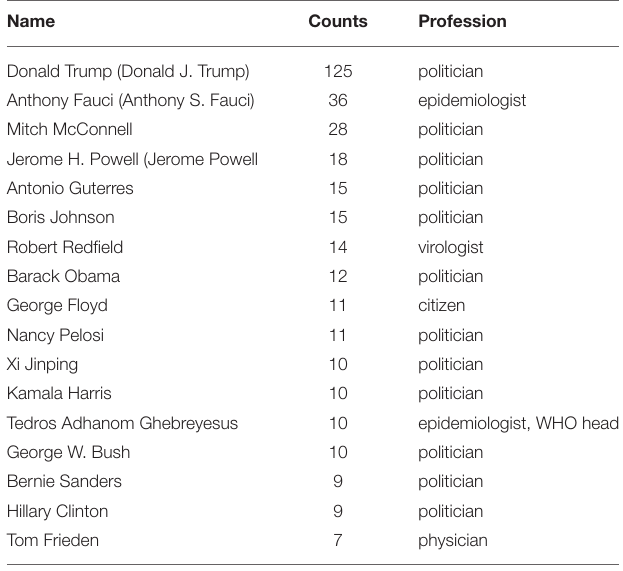
TABLE 4 | Twenty most mentioned names identified in the extracted forward-looking statements. In brackets, we give different spellings for person names, wherever